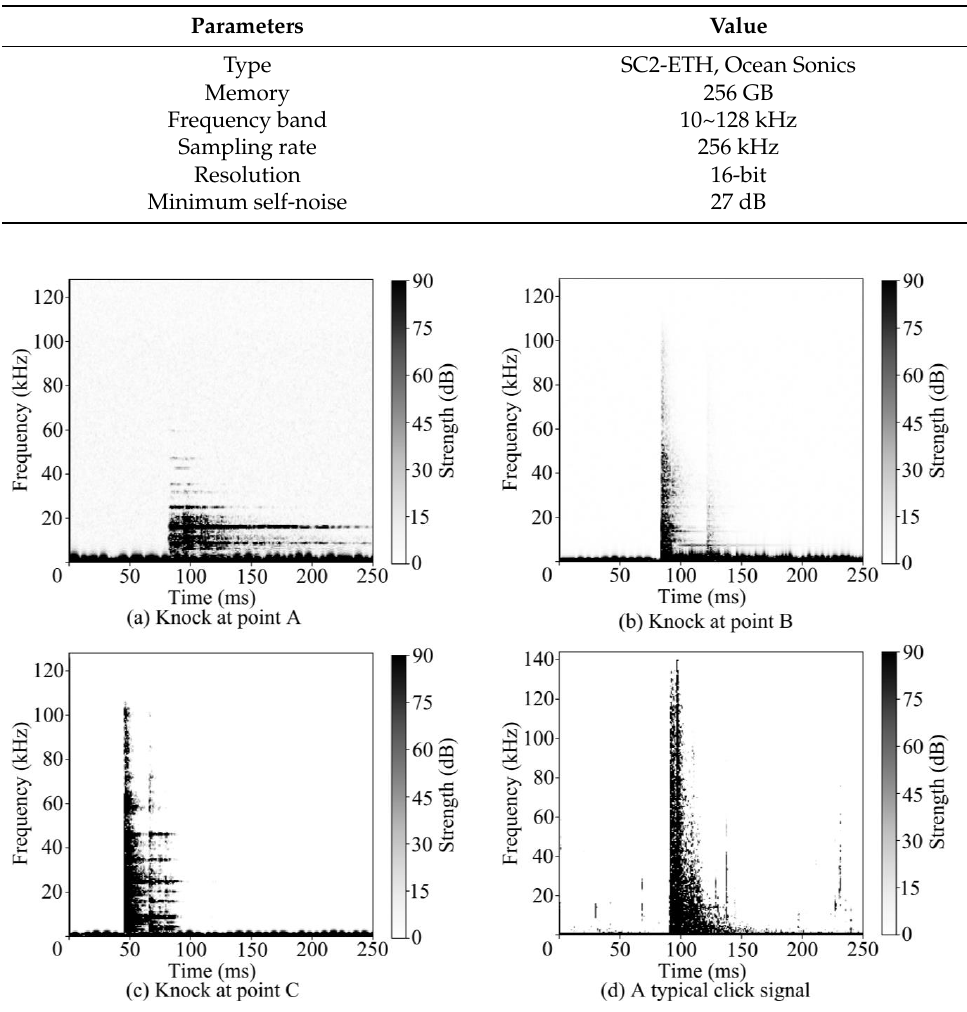
Figure 6. The time–frequency spectrum of clicks and knocking sounds. ( a ) A knock sound at point A. ( b ) A knock sound at point B. ( c ) A knock sound at point C. ( d ) A typical click signal. Table 7. The misdetection numbers of the different methods.